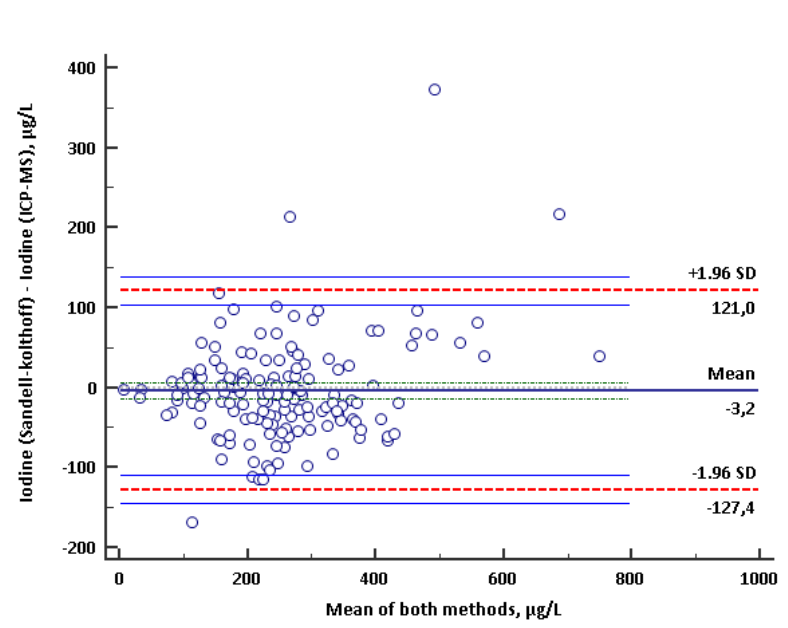
Figure A1. Bland–Altman analysis of urinary iodine measurement ( µ g/L) by ICP-MS and Sandell–kolthoff. The scatter diagram plots the difference of values against the averages of values of the two methods.